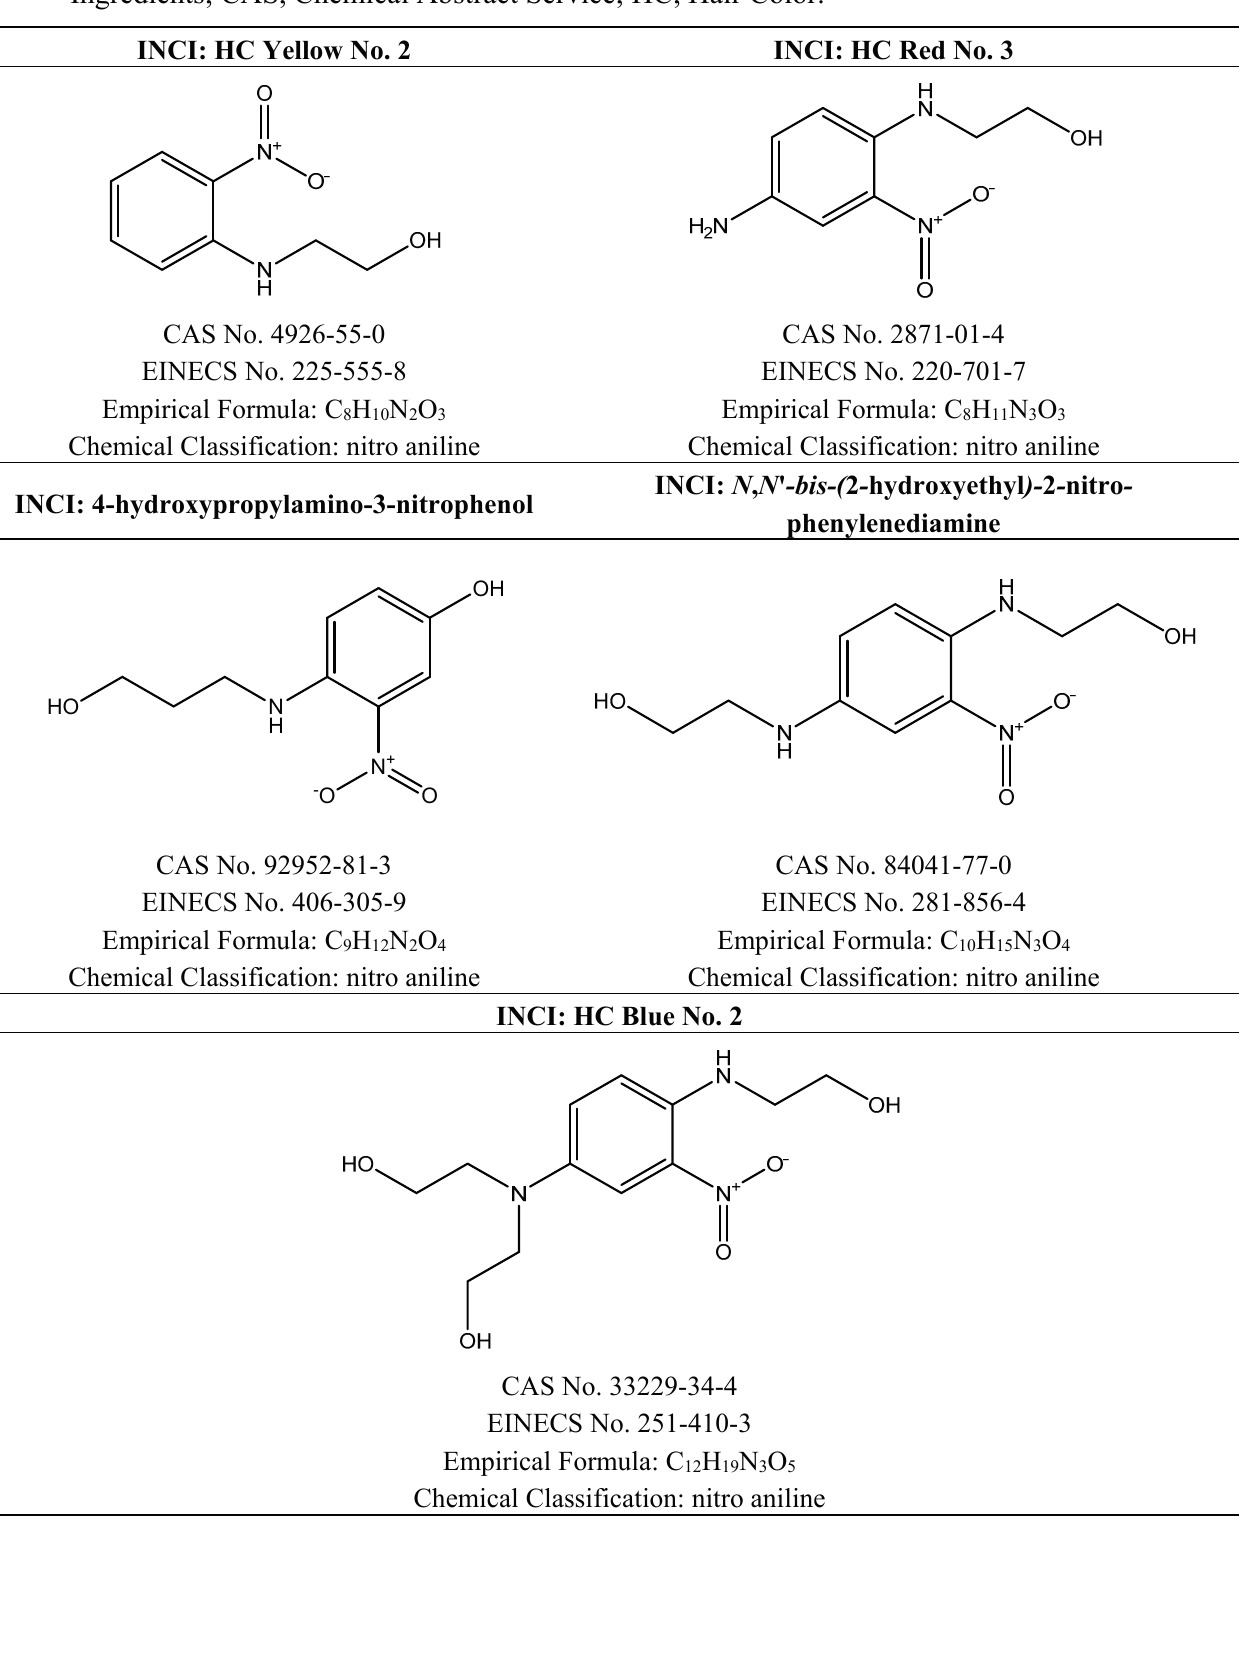
Table 2. Structural and molecular formulas of nitro anilines used in semipermanent hair dyeing formulation [23]. Legend: INCI, International Nomenclature of Cosmetic Ingredients; CAS, Chemical Abstract Service; HC, Hair